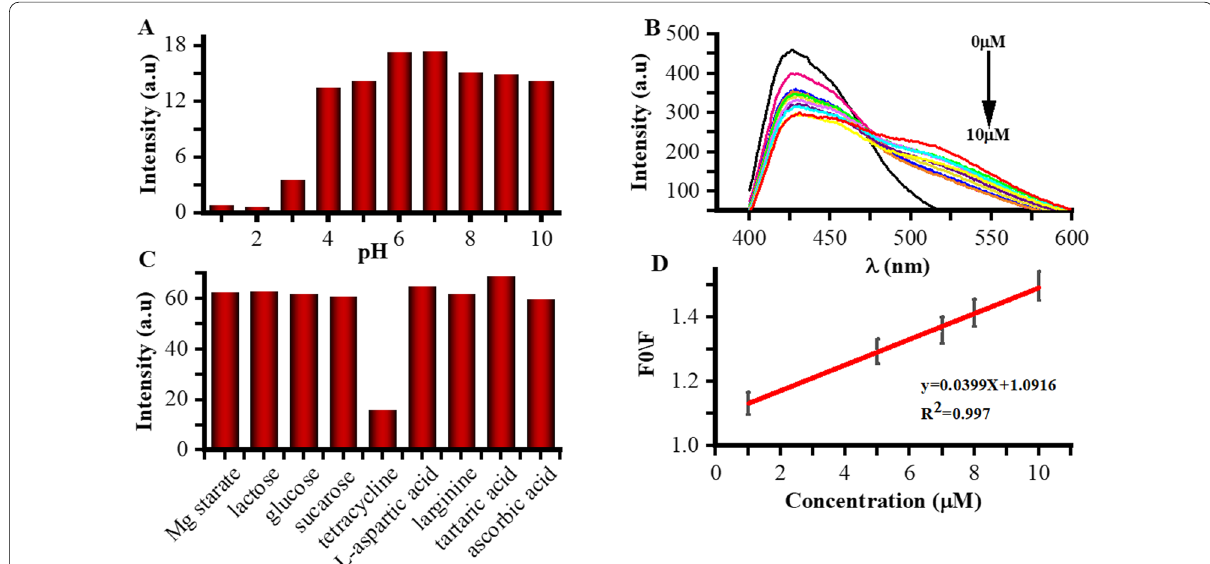
Fig. 5 A Fluorescence spectra of CuNCs@ZIF-8 probe in various pHs. B Fluorescence spectra of CuNCs@ZIF-8 probe upon the exposure of various concentrations of TC, C selectivity test for CuNCs@ZIF-8. D Calibration regression curve (The experimental conditions were λ ex incubation times 5 min) =